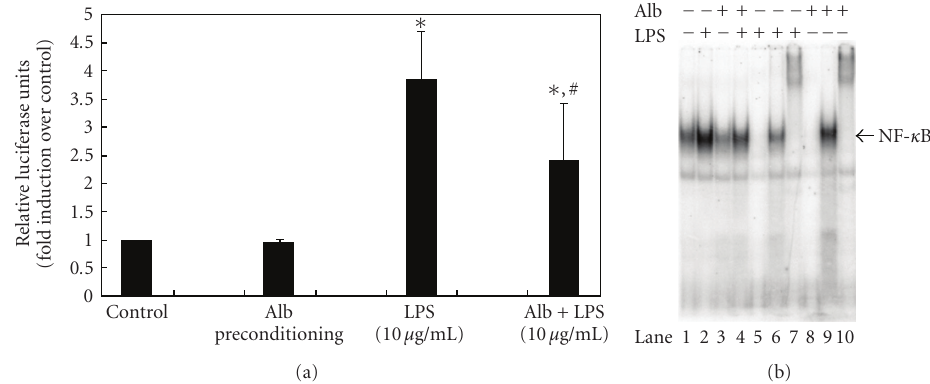
Figure 4: Albumin preconditioning attenuates LPS-mediated NF- κ B activation. (a) NF- κ B luciferase experiments. RAW264.7 peritoneal macrophages were transiently transfected with a 3x NF - κ B/luc reporter plasmid. Cells were allowed to recover overnight and were then preconditioned with BSA (1mg/mL) for 18h prior to a subsequent treatment with LPS (10 μ g/mL). LPS treatment resulted in a significant increase in NF- κ B promoter activation, which was significantly inhibited by albumin preconditioning. All experiments were performed in triplicate with 3 wells per condition ( ∗ P < . 05 compared to control; # P < . 05 compared to LPS alone). (b) EMSA. RAW264.7 peritoneal macrophages were preconditioned with BSA (1mg/mL) for 18h prior to a subsequent treatment with LPS (10 μ g/mL). Nuclear protein was harvested at 30 min after LPS and EMSA were performed. LPS treatment resulted in a significant increase in NF- κ B binding (Lane 2) compared to either control (Lane 1) or albumin preconditioning alone (Lane 3). Albumin preconditioning abrogated NF- κ B binding (Lane 4) compared to LPS alone. Lane 5 (LPS treatment, cold competitor), Lane 6 (LPS treatment, p65 supershift), Lane 7 (LPS treatment, p50 supershift), Lane 8 (Alb+ LPS,cold competitor), Lane 9 (Alb+ LPS, p65 supershift), and Lane 10 (Alb+LPS, p50 supershift) were performed as additional controls to demonstrate specificity and the nature of the NF- κ B. The EMSA shown is representative of 3 separate experiments, all with similar results.